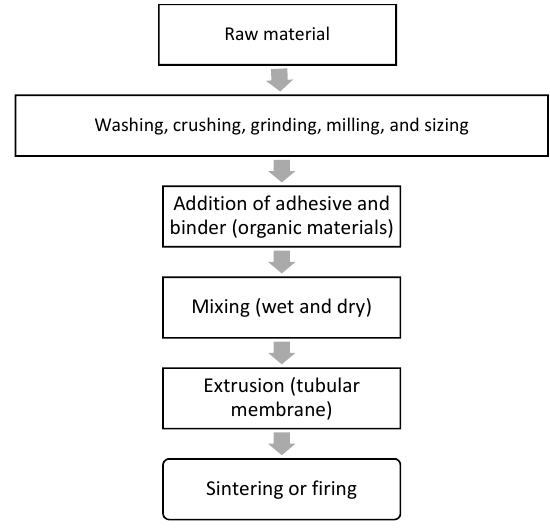
Figure 4. Flow diagram for fabrication of ceramic membrane .